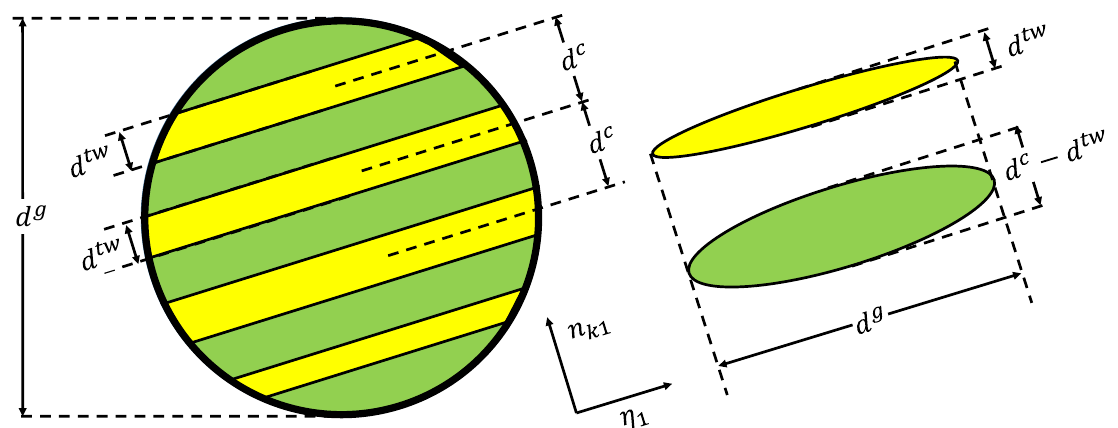
Figure 8. A schematic representing the composite grain (CG) model data from [4] and uncoupled twin-matrix domains with their characteristic lengths. The ellipsoids representing twins and matrix are rotated to orient such that major and minor axes are aligned with twin plane, η 1 , and plane normal, n K 1